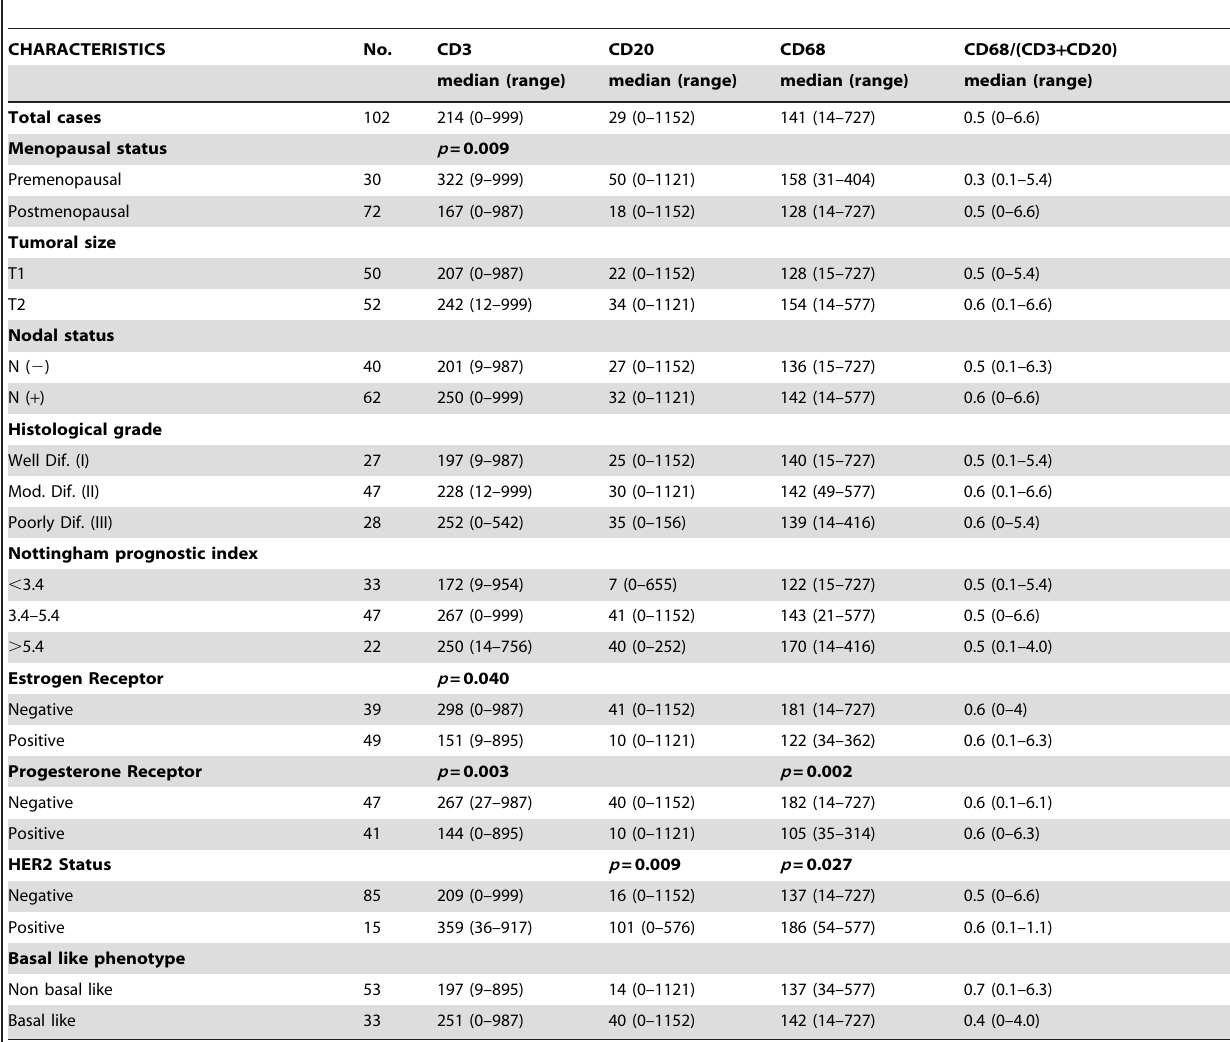
Table 2. Relationship between inflammatory cells count or ratio and clinico- pathological characteristics in 102 patients with invasive ductal carcinoma of the